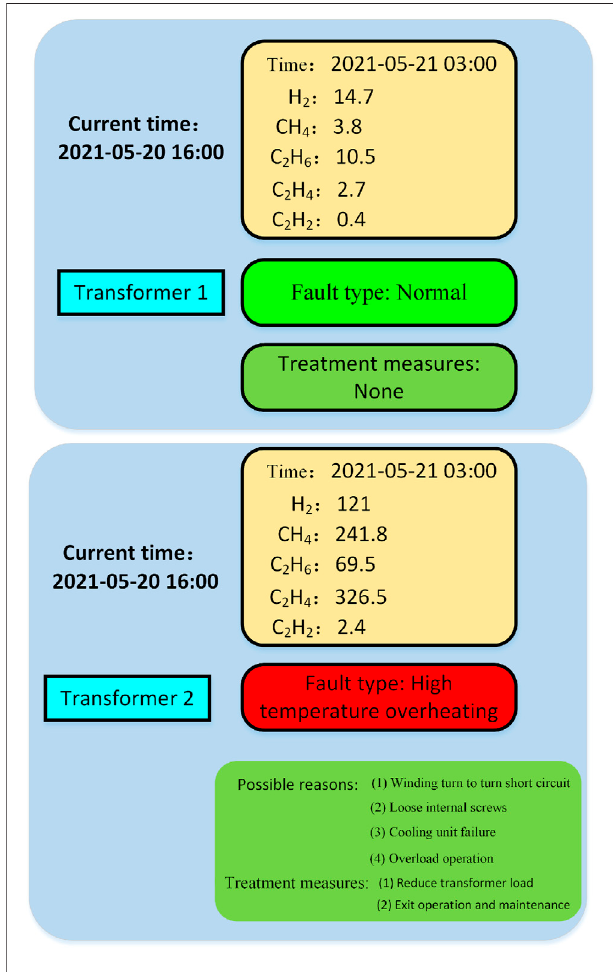
FIGURE 4 | Application of the transformer fault